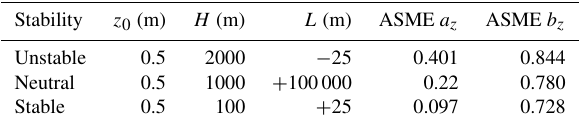
Table 1. Parameters used for calculating the curves shown in Fig. 3.